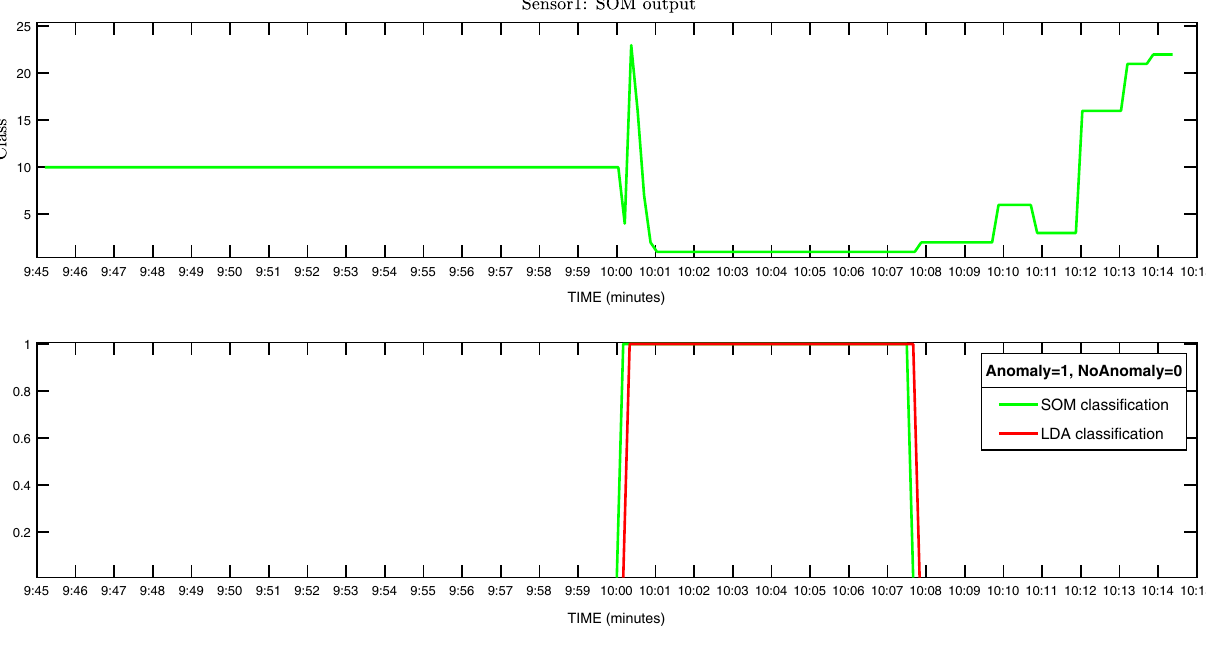
Fig. 7 Anomaly detection for Sensor1 using proposed approach [40, 44]